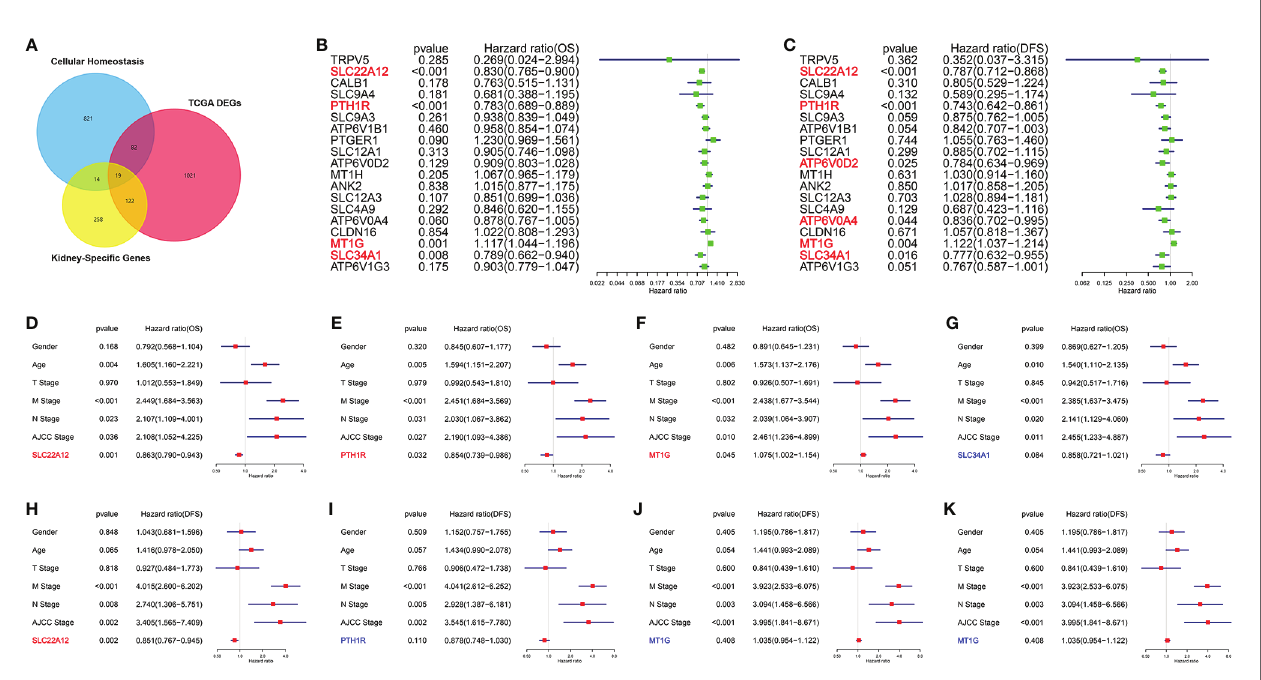
FIGURE 1 | Screening of critical genes involved in cellular homeostasis in ccRCC. (A) Venn diagram selects 19 kidney-speci fi c DEGs involved in cellular homeostasis. (B, C) Univariate Cox regression analyses of 19 selected genes select SLC22A12, PTH1R, MT1G and SLC34A1 as four prognostic biomarkers. Left: OS; right: DFS. (D – K) Multivariate Cox regression analyses of four candidate prognostic biomarkers along with clinicopathological characteristics select SLC22A12 as the critical gene. Middle row: OS; bottom row: